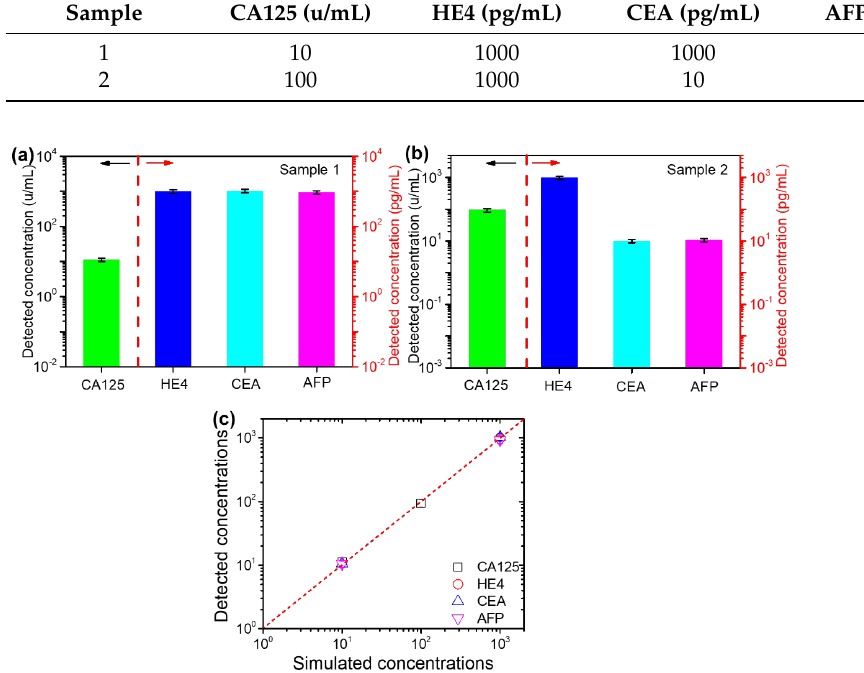
Figure 5. The detection results of the simulated protein biomarker in the serum of simulated sample 1 ( a ) and sample 2 ( b ). The relationship between the simulated and detected sample concentrations ( c ). Note: the dotted line in ( a , b ) is the separation line of the Y axis, left side corresponding to left axis, right side corresponding to right axis; the red line in ( c ) is X = Y.